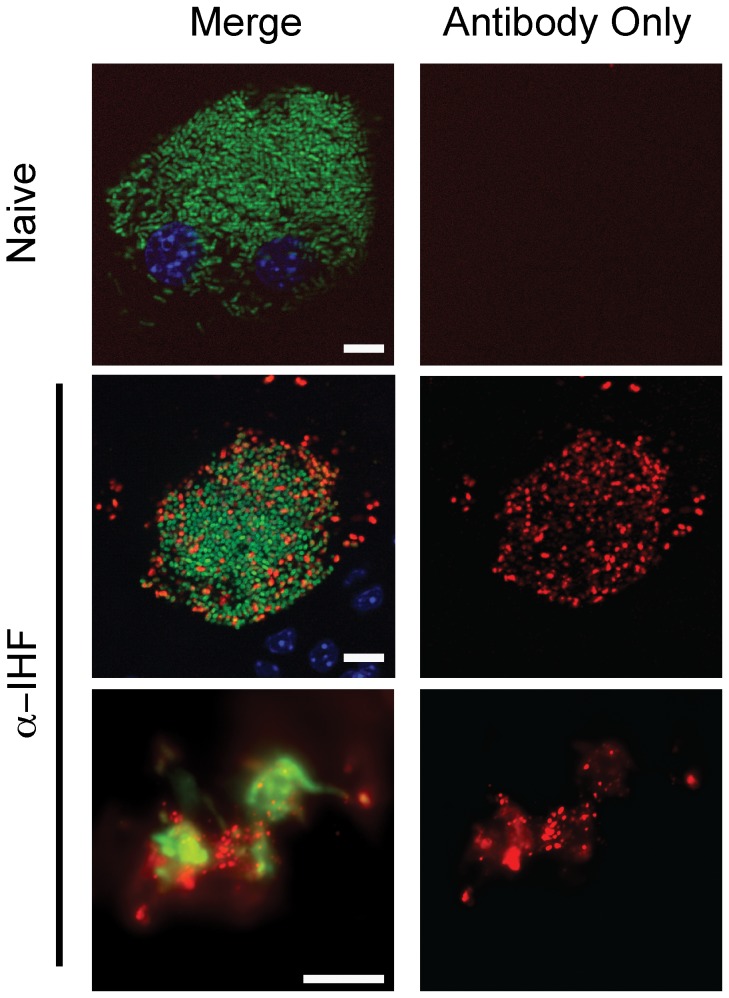
IhfAB is extrabacterial within the IBC milieu.Bladders were removed at 16 hours following transurethral introduction of UTI89/pANT4 (green). At 16 hours post introduction of bacteria, the bladders were harvested, bisected, fixed, host cells permeabilized and eIhfAB was observed with antibody (red) and Hoescht counterstained (blue). (A, D) No staining is observed when naïve rabbit serum is used as primary antibody. (B,E) eIhfAB is observed between the bacteria within the epithelial cell. (C, F) eIhfAB remains associated with UPEC following egress onto the surface of the bladder. Scale bar  = 10 µm.